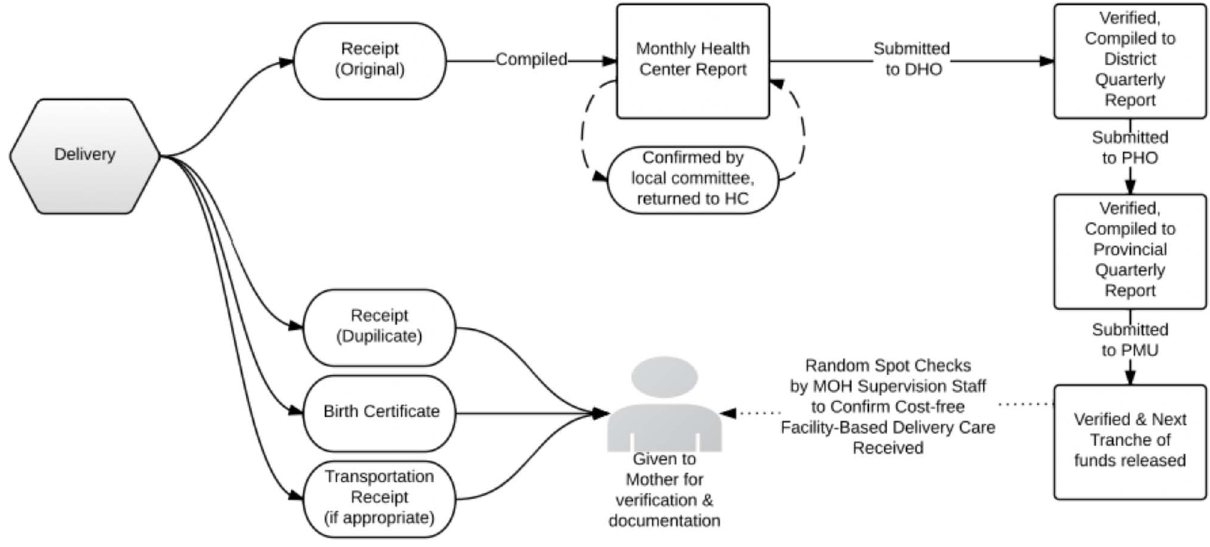
Figure 2. Reporting Flows for the Free Delivery Pilot. doi:10.1371/journal.pone.0089784.g002 PLOS ONE |